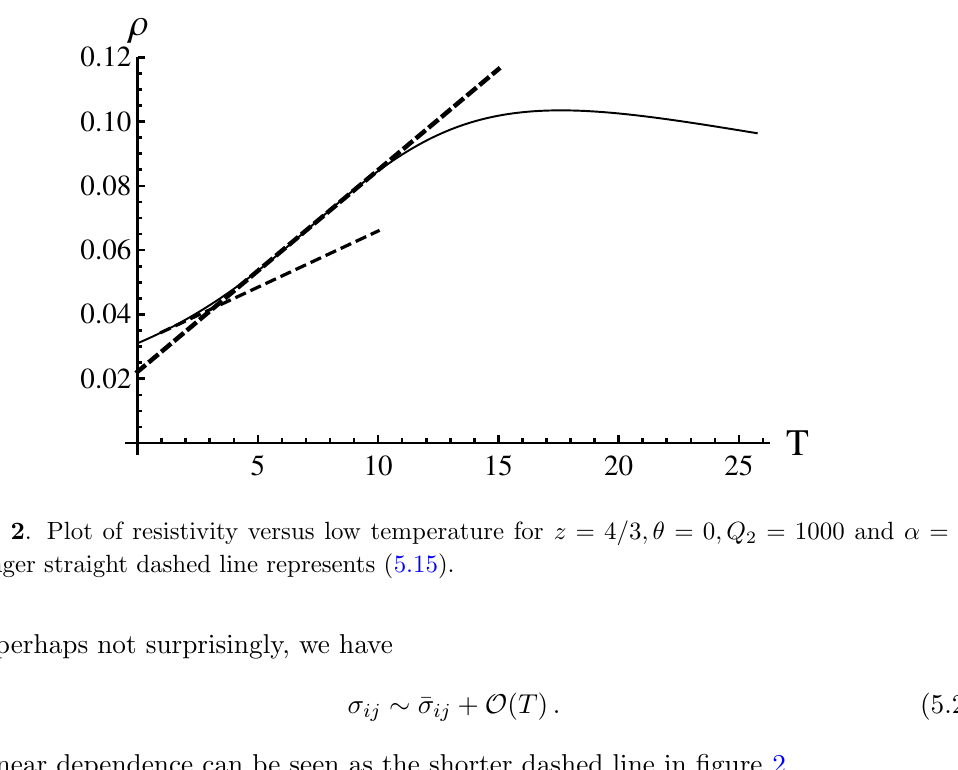
Figure 1 . Plot of resistivity versus temperature for z = 4 = 3 ; (cid:18) = 0 ; Q 2 = 1000 and (cid:11) = 10, showing a transition from a linear regime to a decaying region. The resistivity (cid:26) 2 ( T ) is plotted as a solid thin line. The straight dashed line on the left represents (5.15), while the curved dashed line on the right represents (5.17).